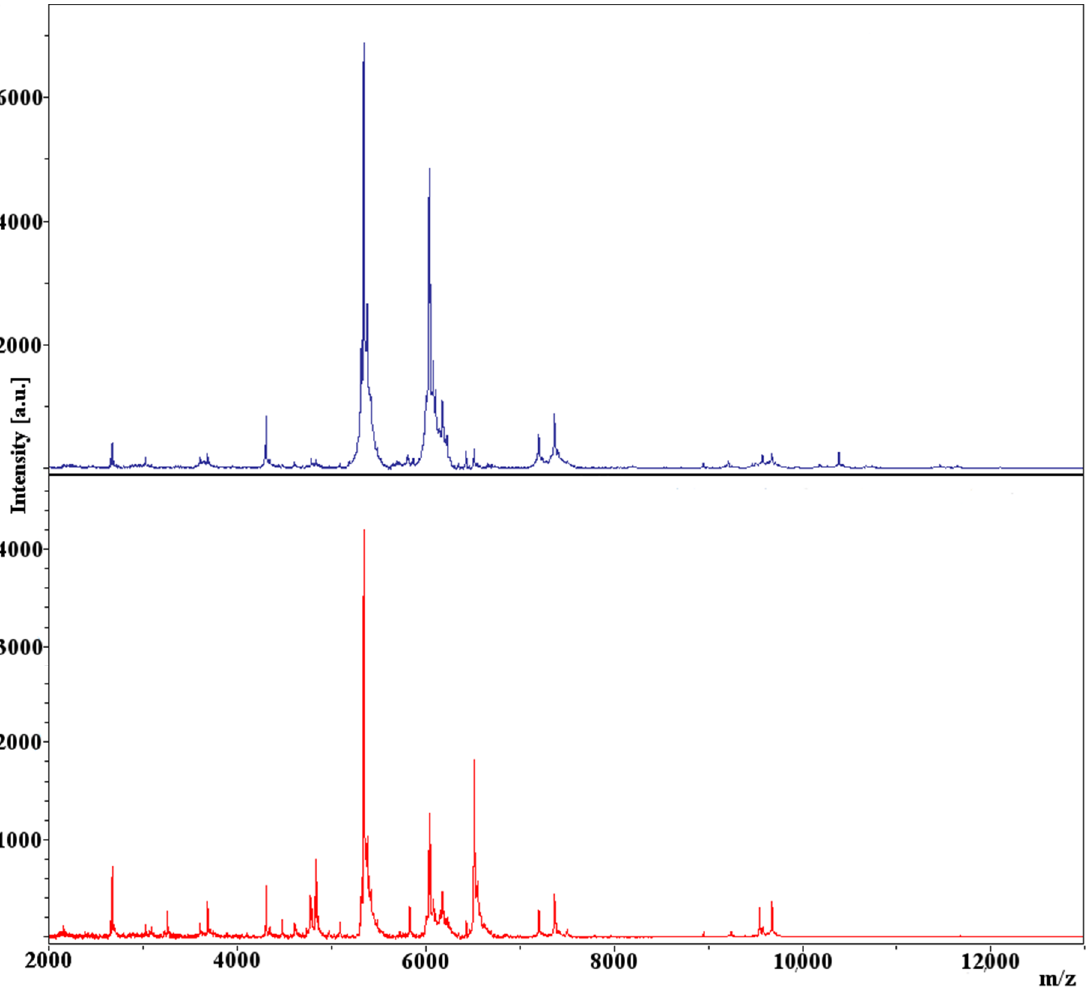
Figure 3. Representative spectra generated from samples of isolates of Knoxville-1 ( top ) and W9 ( bottom ). W9 ( bottom